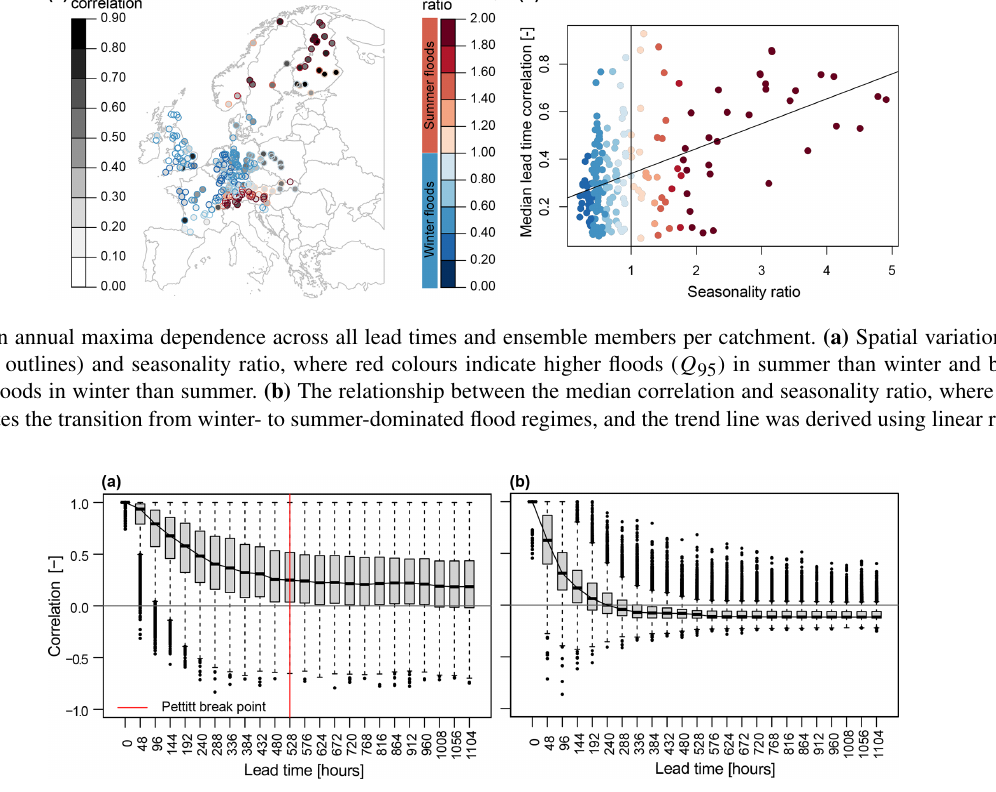
Figure 7. Median Spearman’s correlation across ensemble members and catchments per lead time (0 to 1104h) for (a) annual maxima and (b) peak-over-threshold events. The median correlation per lead time is indicated by the horizontal grey line, and the break point in this median series derived by the Pettitt test at the vertical red line. No red line is shown in panel (b) , as the break point was determined using the AM series shown in panel (a)